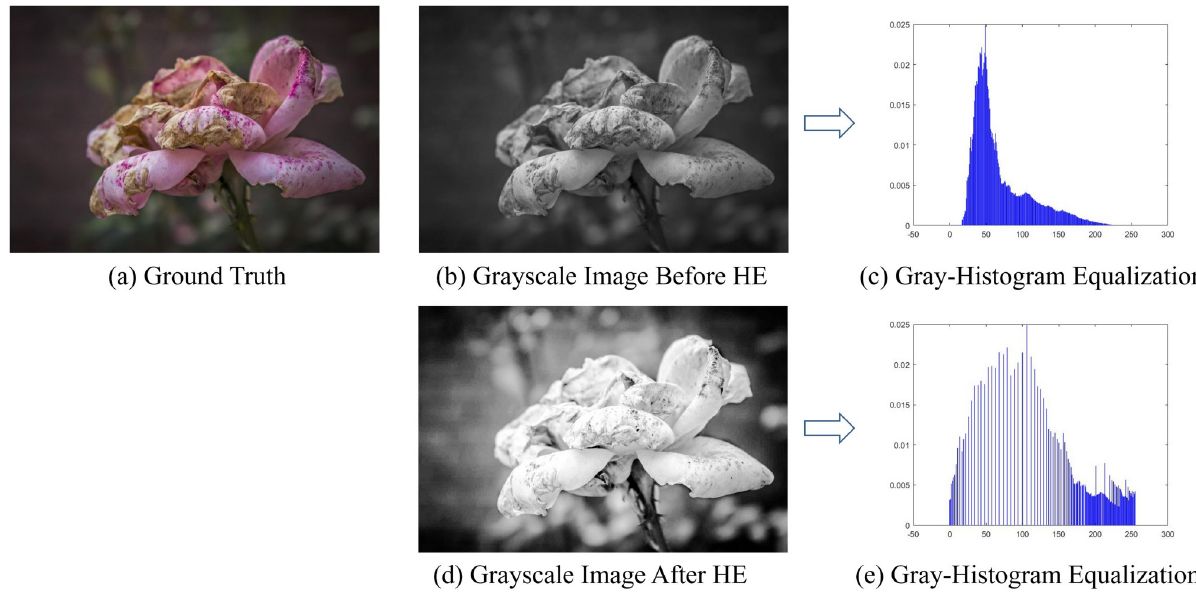
Fig 5. The image and its histogram before and after gray-histogram equalization.